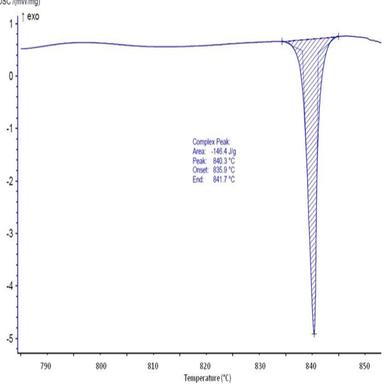
DSC results for H845 molten salt PCM freeze and melt temperature profile.